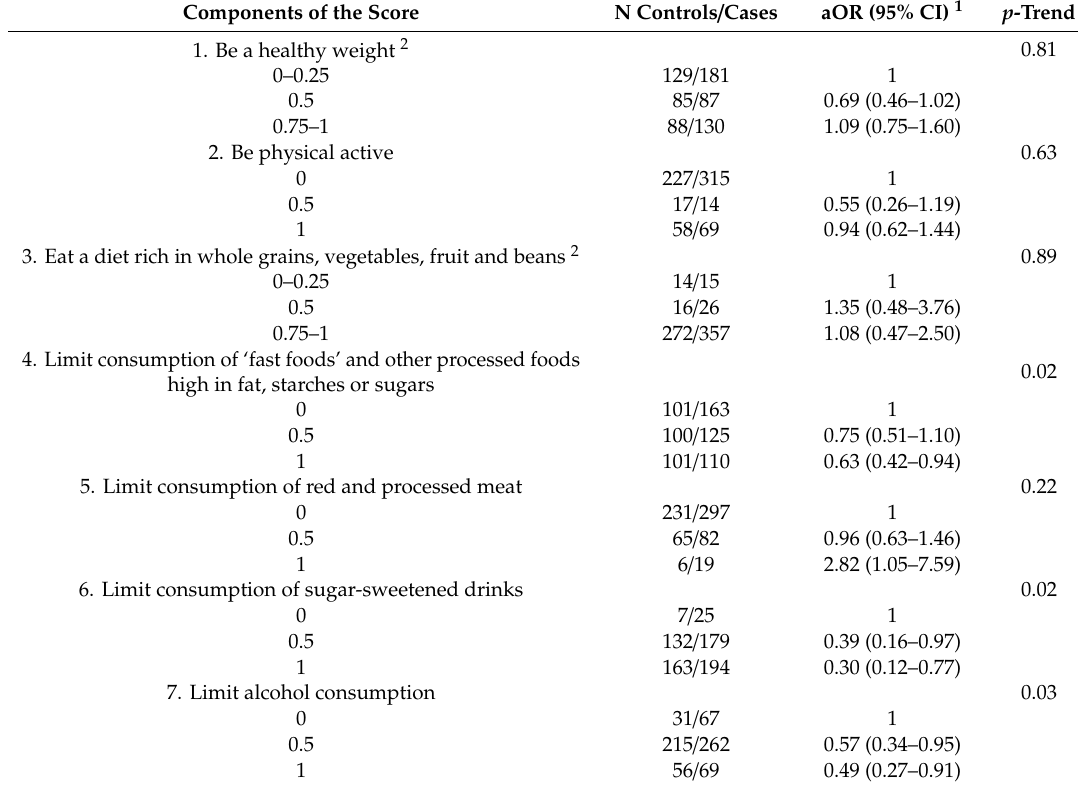
Table 5. Mutually adjusted odds ratios and 95% confidence intervals for PCa associated with the components of the 2018 WCRF / AICR score in CAPLIFE